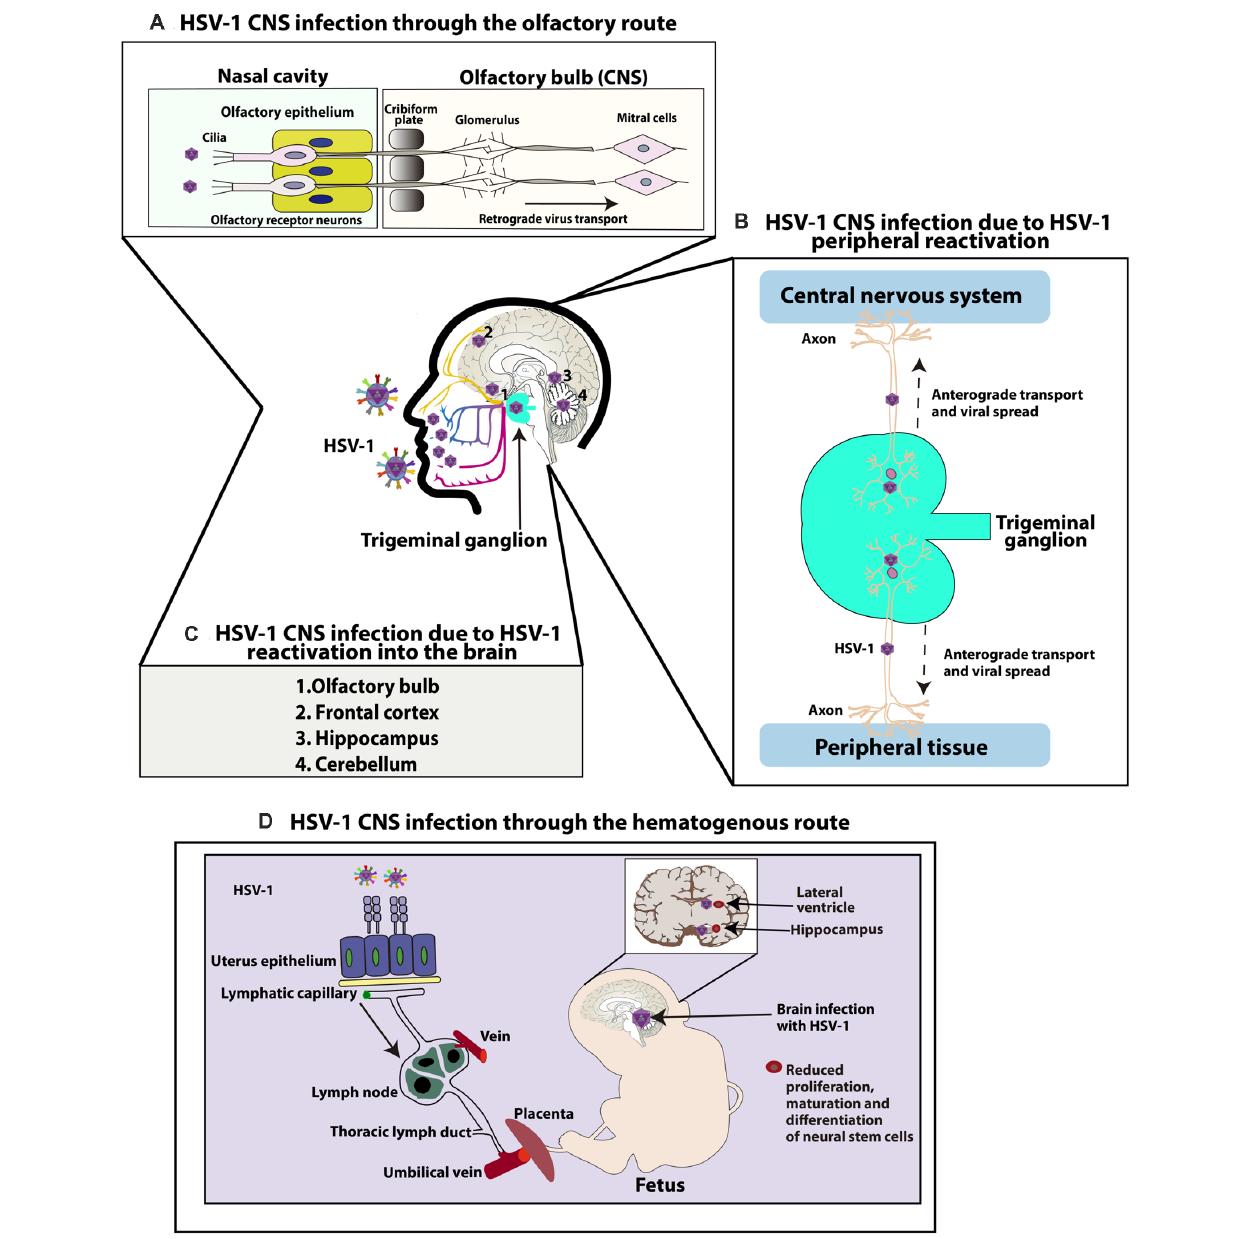
FIGURE 1 | Central nervous system (CNS) infection with herpes simplex virus type 1 (HSV-1). (A) HSV-1 CNS infection through the olfactory route: HSV-1 can infect the termini of olfactory neurons enervating the nasal epithelium and access the CNS by retrograde axonal transport through neurons until reaching the olfactory bulb in the brain. (B) HSV-1 can also infect the CNS because of HSV-1 peripheral reactivation. HSV-1 can reactivate from neurons in the trigeminal ganglia (TG) and reach either the skin or CNS through anterograde transport. (C) HSV-1 can also reach different regions of the CNS because of HSV-1 reactivation within the brain. Reactivation of latent virus within the CNS has been reported to reach the cerebellum, olfactory bulb, frontal cortex, or hippocampus. (D) Finally, HSV-1 can infect the CNS through a hematogenous route. HSV-1 can infect the CNS of fetuses because of HSV-1 infection in the mother, through the bloodstream by accessing the placenta. Once the fetus is infected, HSV-1 accesses the brain and has been reported to infect the hippocampus. Neural stem cells (NSCs) in the subventricular zone of the lateral ventricle and subgranular zone of the hippocampus have been shown to be infected by HSV-1, affecting the maturation and proliferation, as well as differentiation of these